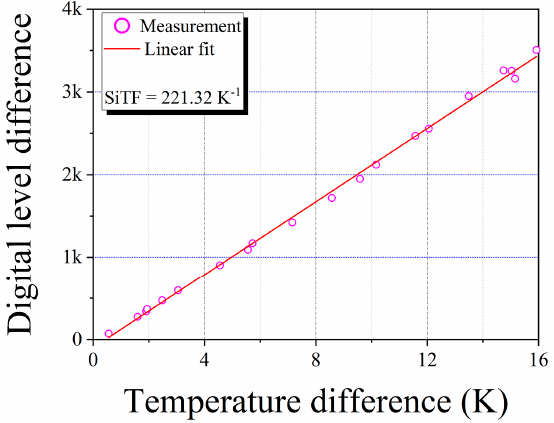
Figure 6. Signal transfer function (SiTF) curve of the portable and large-area blackbody system.